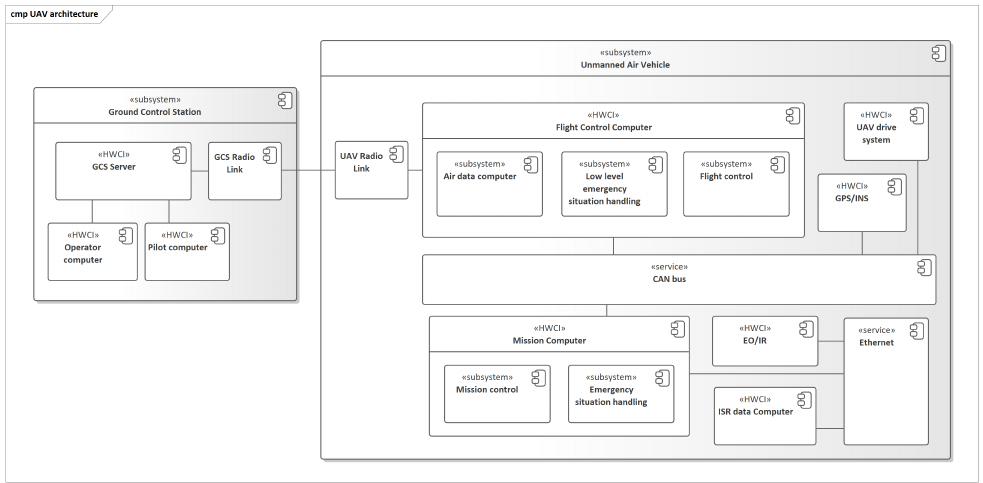
Figure 4. Physical architecture of UAV with logical units depicted (collision avoidance modules). The figure shows GCS components and UAV components with the radio data link